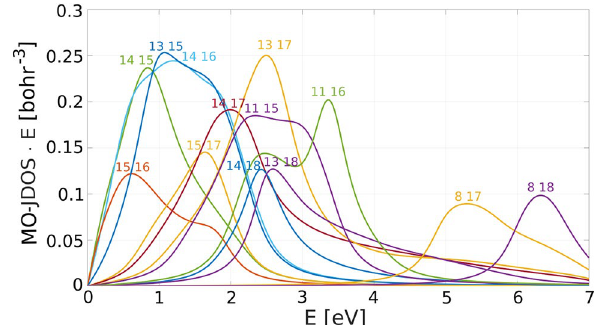
Figure 6. Selected transitions of MO-JDOS multiplied by energy. The numbers denote the initial and final bands. Transitions contributing negatively to the spectrum tend to have larger